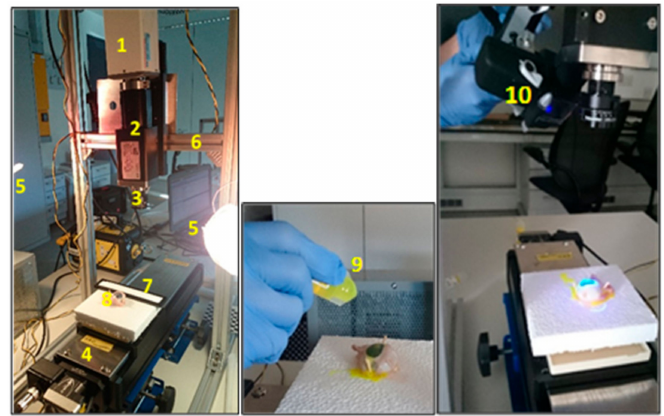
Figure 2. Column 1: Experimental setup. (1) CCD Camera; (2) Spectrograph; (3) Lens; (4) Translation stage; (5) Left and right halogen lamp; (6) Frame; (7) Spectralon/white panel; (8) Sample/porcine eye, Column 2: (9) Staining process, Column 3: (10) Blue lamp illumination source for stained